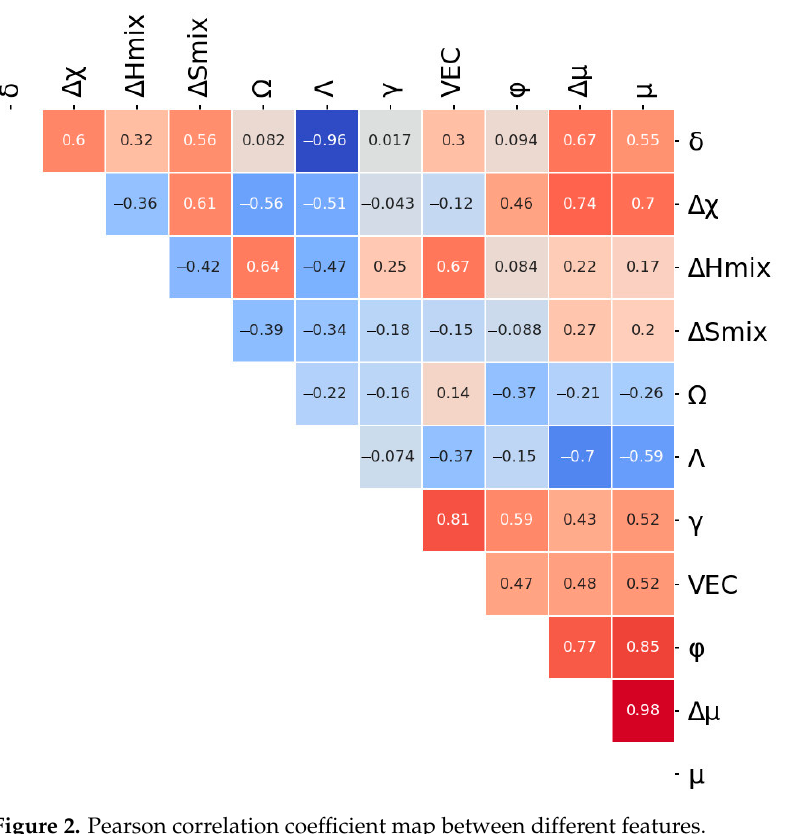
Figure 2. Pearson correlation coefficient map between different features.